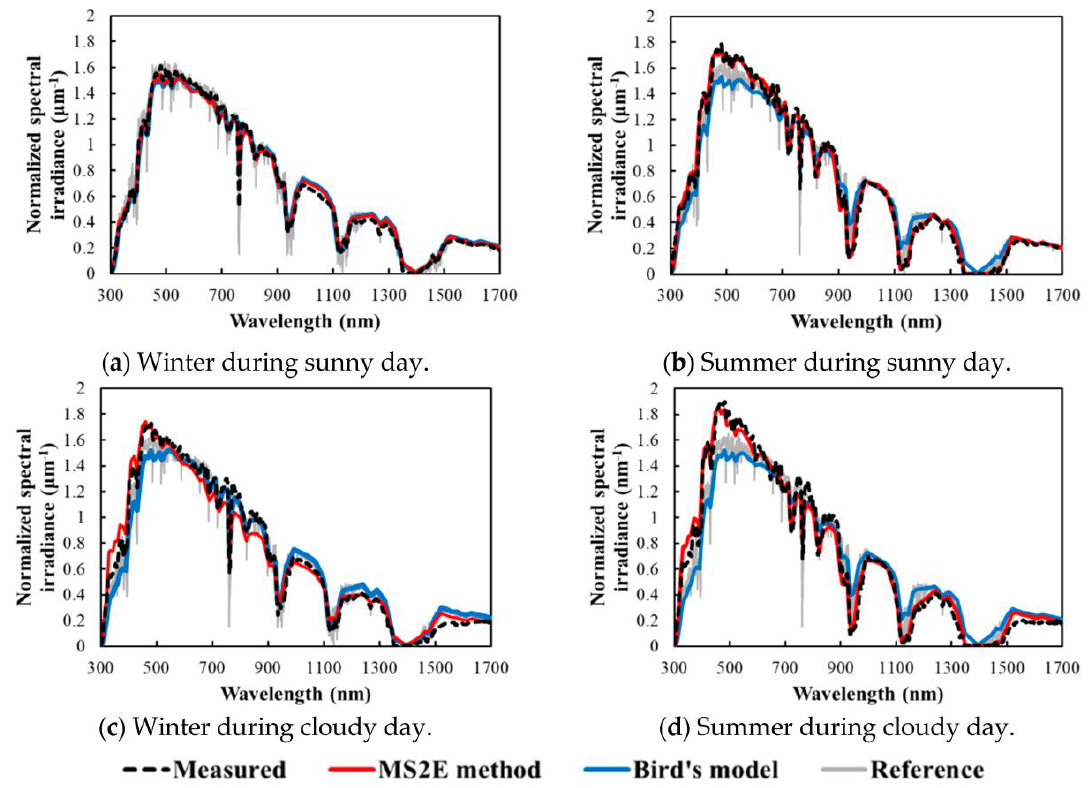
Figure 3. Comparison with measured and estimated values (Bird’s model and Miyazaki Spectrum-to-Energy (MS2E) model) of global irradiances tilted at 35° [97]: ( a ) Solar spectrum in the sunny day in winter; ( b ) Solar spectrum in the sunny day in summer; ( c ) Solar spectrum in the cloudy day in winter; ( d ) Solar spectrum in the cloudy day in summer.